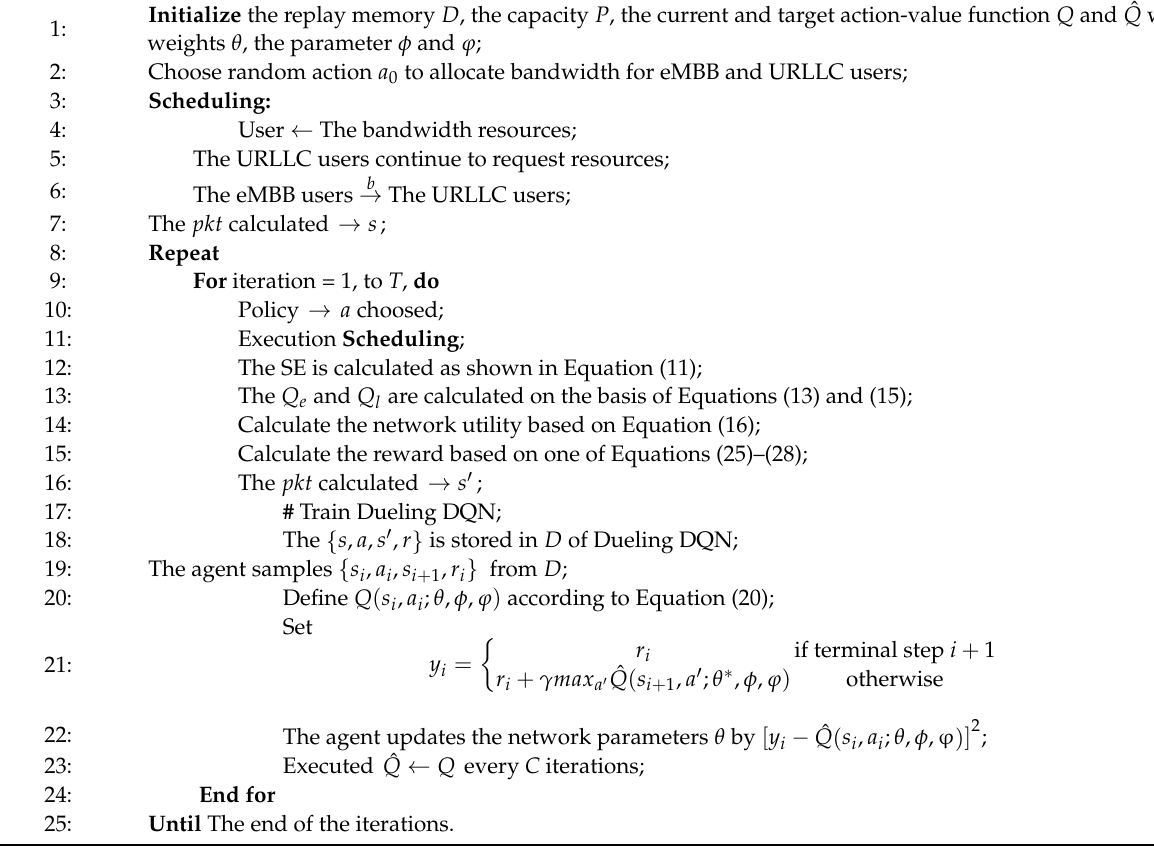
Algorithm 1. The Dueling DQN based slicing resource allocation and